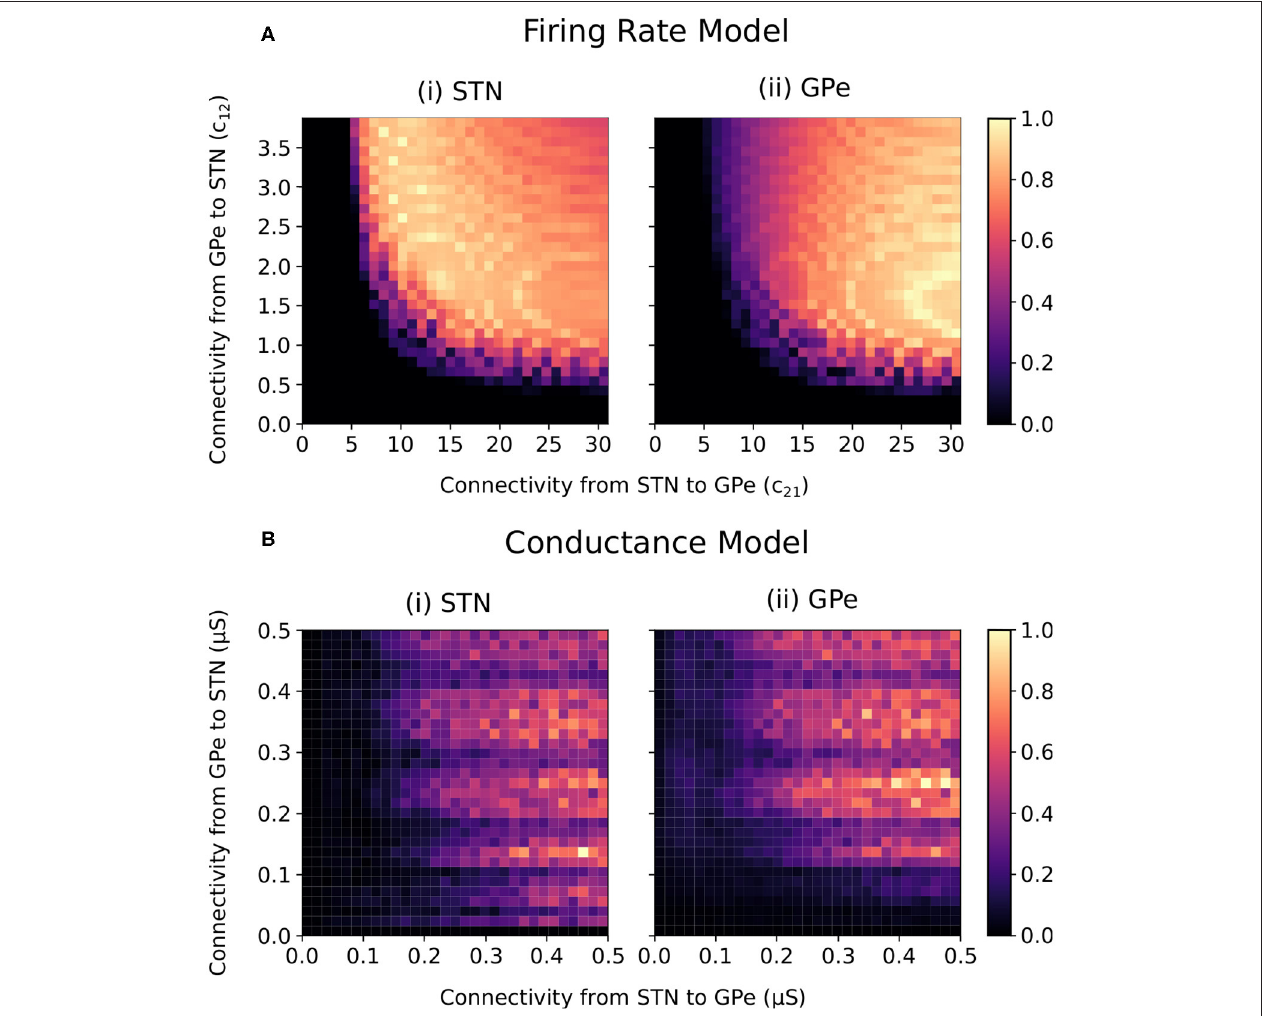
FIGURE 2 | Normalized endogenous beta-band activity in the firing rate and conductance-based models for varying STN and GPe coupling strengths. (A) Beta-band oscillation amplitude in the (i) STN and (ii) GPe of the firing rate model. The beta-band oscillation amplitude in each population was estimated for each combination of connectivity parameters ( c 12 and c 21 ) by band-pass filtering the firing rate signals using a fifth order Butterworth filter with 8 Hz bandwidth centered on 20Hz. The oscillation amplitude in each population was normalized between 0 and 1 in each panel separately. (B) Beta-band activity of the (i) STN and (ii) GPe populations in the conductance-based model. Beta-band activity was quantified in each population by integrating the power spectra of the cumulative spike trains for each population between 16 and 24 Hz. The power for each population was normalized between 0 and 1 in each panel